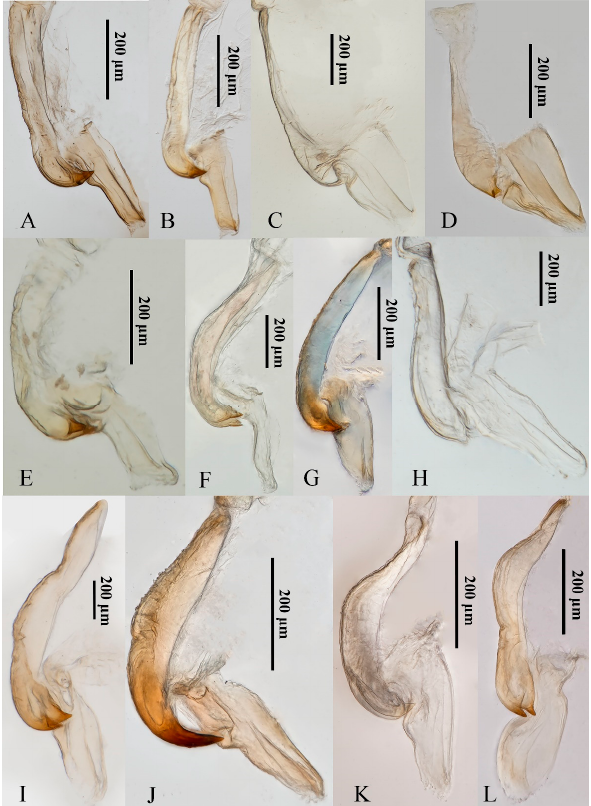
Figure 8. The paraphysis and aedeagus of 12 Atkinsoniella species. ( A ) Atkinsoniella aurantiaca ; ( B ) A . curvata ; ( C ) A . flavipenna ; ( D ) A . longiuscula ; ( E ) A . thalia ; ( F ) A . thaloidea ; ( G ) A . tiani ; ( H ) A . uniguttata ; ( I ) A . warpa ; ( J ) A . wui ; ( K ) A . xanthoabdomena ; ( L ) A . yunnanana . 4. Discussion In this study, complete mitochondrial genomes of 12 yellow-winged Atkinsoniella species with similar morphological characteristics ( A . aurantiaca , A . curvata , A . flavipenna , A . longiuscula , A . thalia , A . thaloidea , A . tiani , A . uniguttata , A . warpa , A . wui , A . xanthoabdo- mena , A . yunnanana ) were newly sequenced and analyzed. The sizes of the 12 mitoge- nomes varied from 15,034 ( A . thalia ) to 15,988 bp ( A . curvata ), which was mainly due to the variation in the lengths of control regions. The comparative analysis showed that all 12